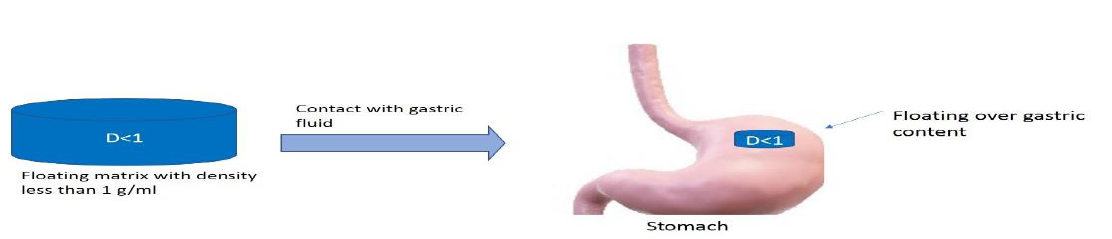
Fig. 1. Illustrative photo of a floating